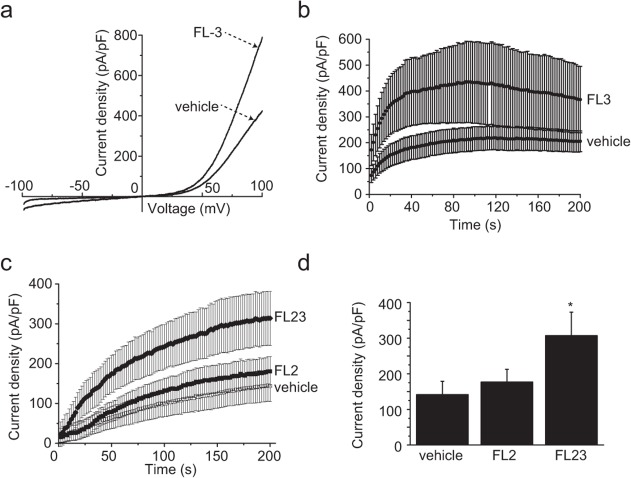
Analogs of FL23 show distinct effects on TRPM6 currents.
a. Typical current-voltage curves obtained 200 s after break-in are shown for vehicle and FL23 (50 nM) pre-incubated cells. b. The average time-course of TRPM6 current development with (n = 8) or without (n = 11) FL23 (50 nM) is shown for current values measured at +80 mV. c. The average time-course of TRPM6 current development with FL2 (50 nM, n = 12), vehicle (n = 10) or FL23 (50 nM, n = 10) pre-treatment is shown for current values measured at +80 mV. d. FL2 incubation did not significantly stimulate TRPM6 activity (n≥10). Stars indicate statistically significant difference (P<0.05) between vehicle and compound-treated cells.